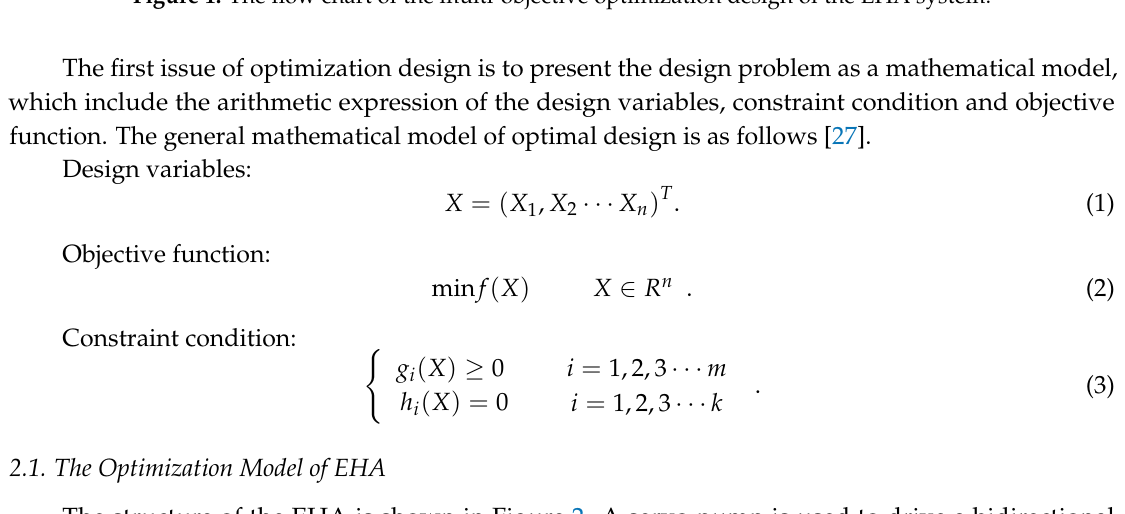
Figure 1. The flow chart of the multi ‐ objective optimization design of the EHA system.